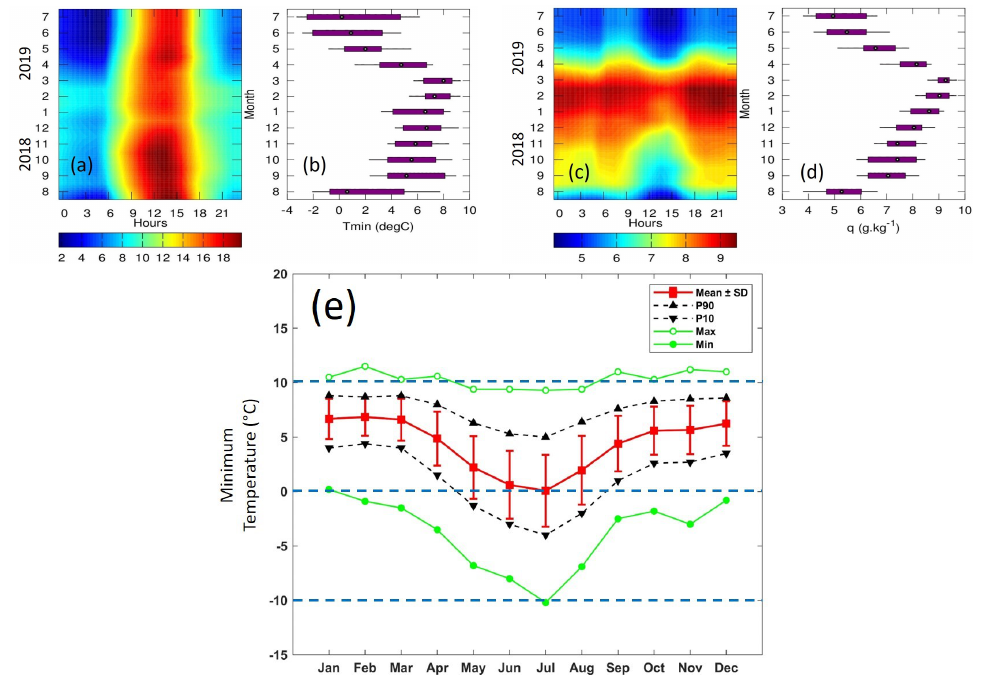
Figure 9. ( a ) Monthly and diurnal cycles of mean hourly temperature ( ◦ C) at 2 m high above the HYO between July 2017 and July 2018. ( b ) Monthly variation of hourly minimum temperature quantiles (boxplot) at 2 m high above the HYO between July 2017 and July 2018. ( c ) Monthly and diurnal cycles of mean water vapor mixing ratio (g kg − 1 ) at 2 m high above the HYO between July 2017 and July 2018. ( d ) Monthly variation of hourly water vapor mixing ratio quantiles (boxplot) at 2 m high above the HYO between July 2017 and July 2018. ( e ) Mean, minimum, maximum, percentile 10% and percentile 90% of minimum temperatures ( ◦ C) between 1965 and 2019 on the